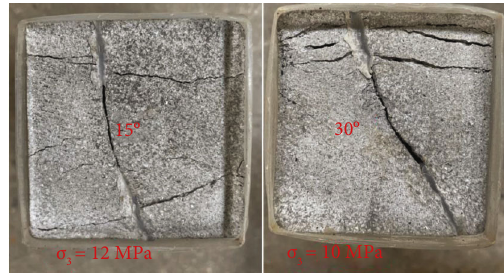
3 ) relationship under di